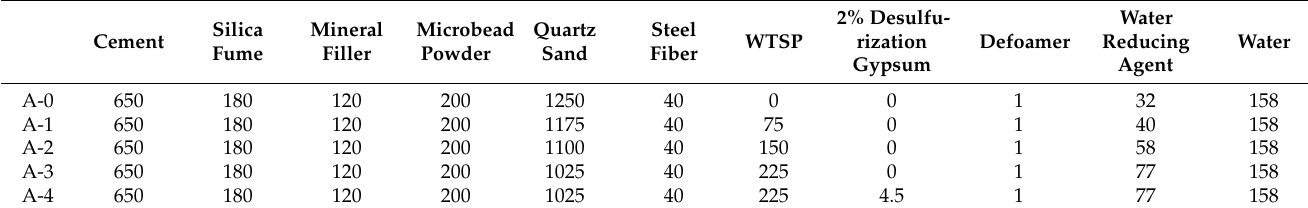
Table 1. Mixing ratio of wet WTSP instead of quartz sand (kg/m 3 ).